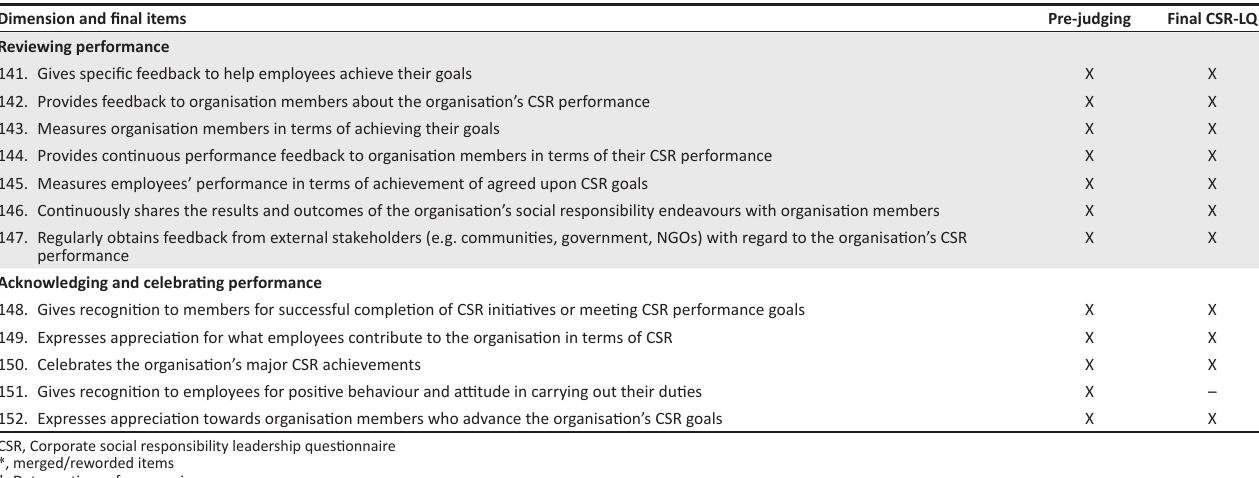
TABLE 4 (Continues): CSR-LQ items prior to and after expert judging. Dimension and final